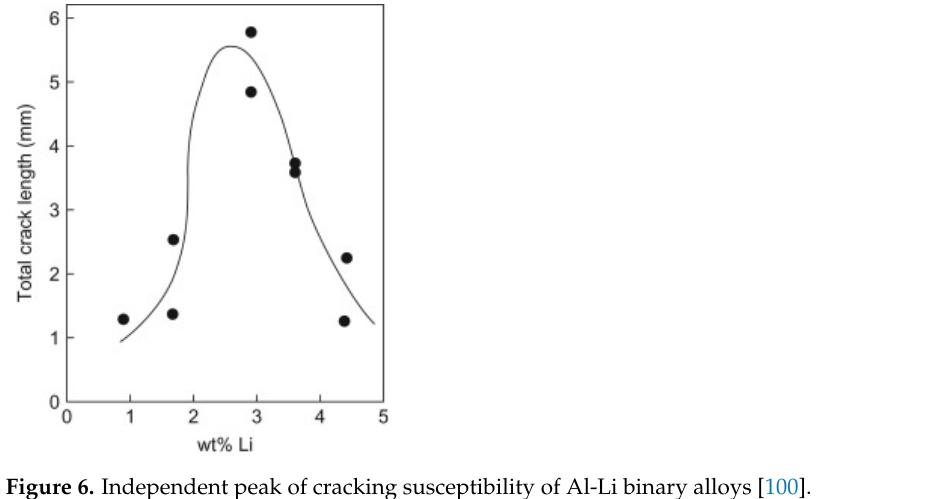
Figure 6. Independent peak of cracking susceptibility of Al-Li binary alloys [100].